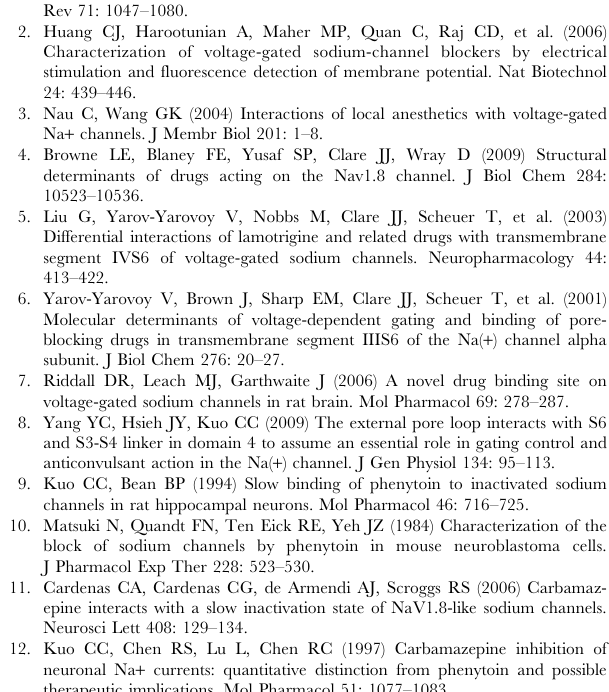
Table S3 Ion channel-specific parameters of the tetracube